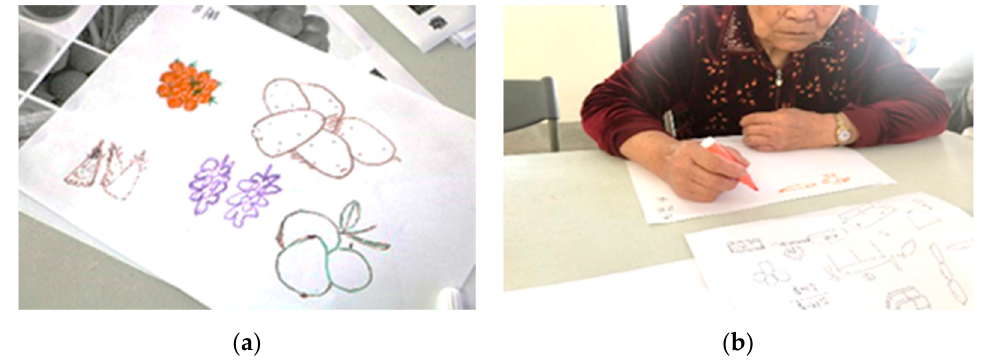
Figure 3. Creations from the Stage 3 IEC workshops. ( a ) Drawing under the theme “Roadside banquet ingredients” (E2-C-Week20). The elders explained the symbolism behind the various food ingredients and recollected happy times on the occasion of the Lunar New Year. ( b ) Drawing under the theme “Roadside banquet ingredients” (E6-C-Week20). The elders gushed eloquently as they recalled the food ingredients.